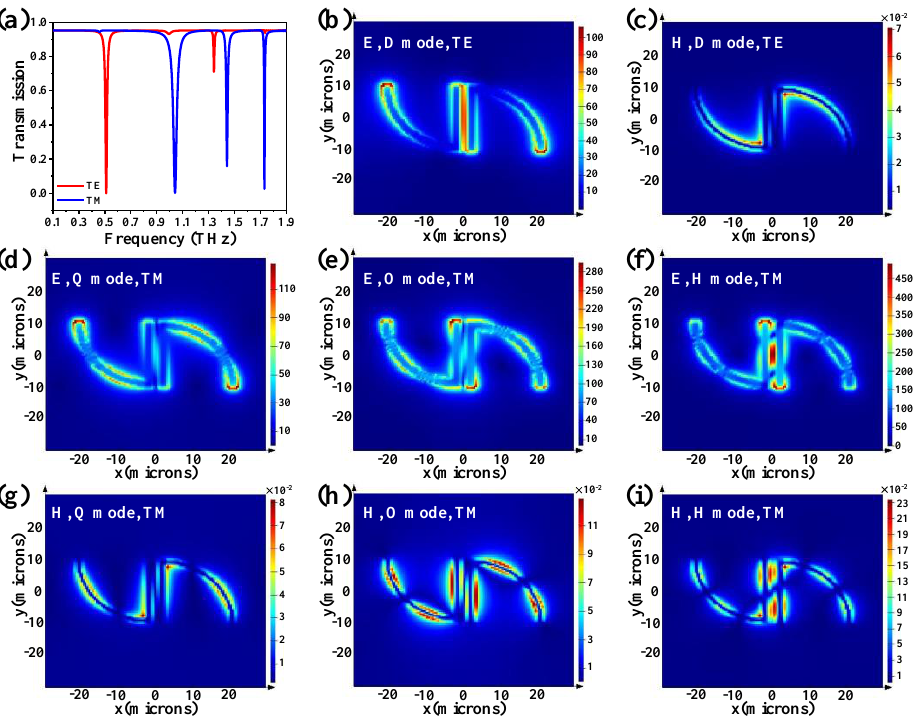
Figure 3. Transmission spectra of SSM and corresponding E- and H-field distributions. ( a ) Transmission spectra of SSM in TE and TM modes under the condition of n b = 1.0. ( b ) E-field and ( c ) H-field distributions of SSM monitored in resonant dipolar mode (D mode) under the incident TE-polarized wave. ( d – f ) E-field and ( g – i ) H-field distributions of SSM monitored at resonant quadrupolar mode (Q mode), octupolar mode (O mode) and hexadecapolar mode (H mode) under the incident TM-polarized wave.